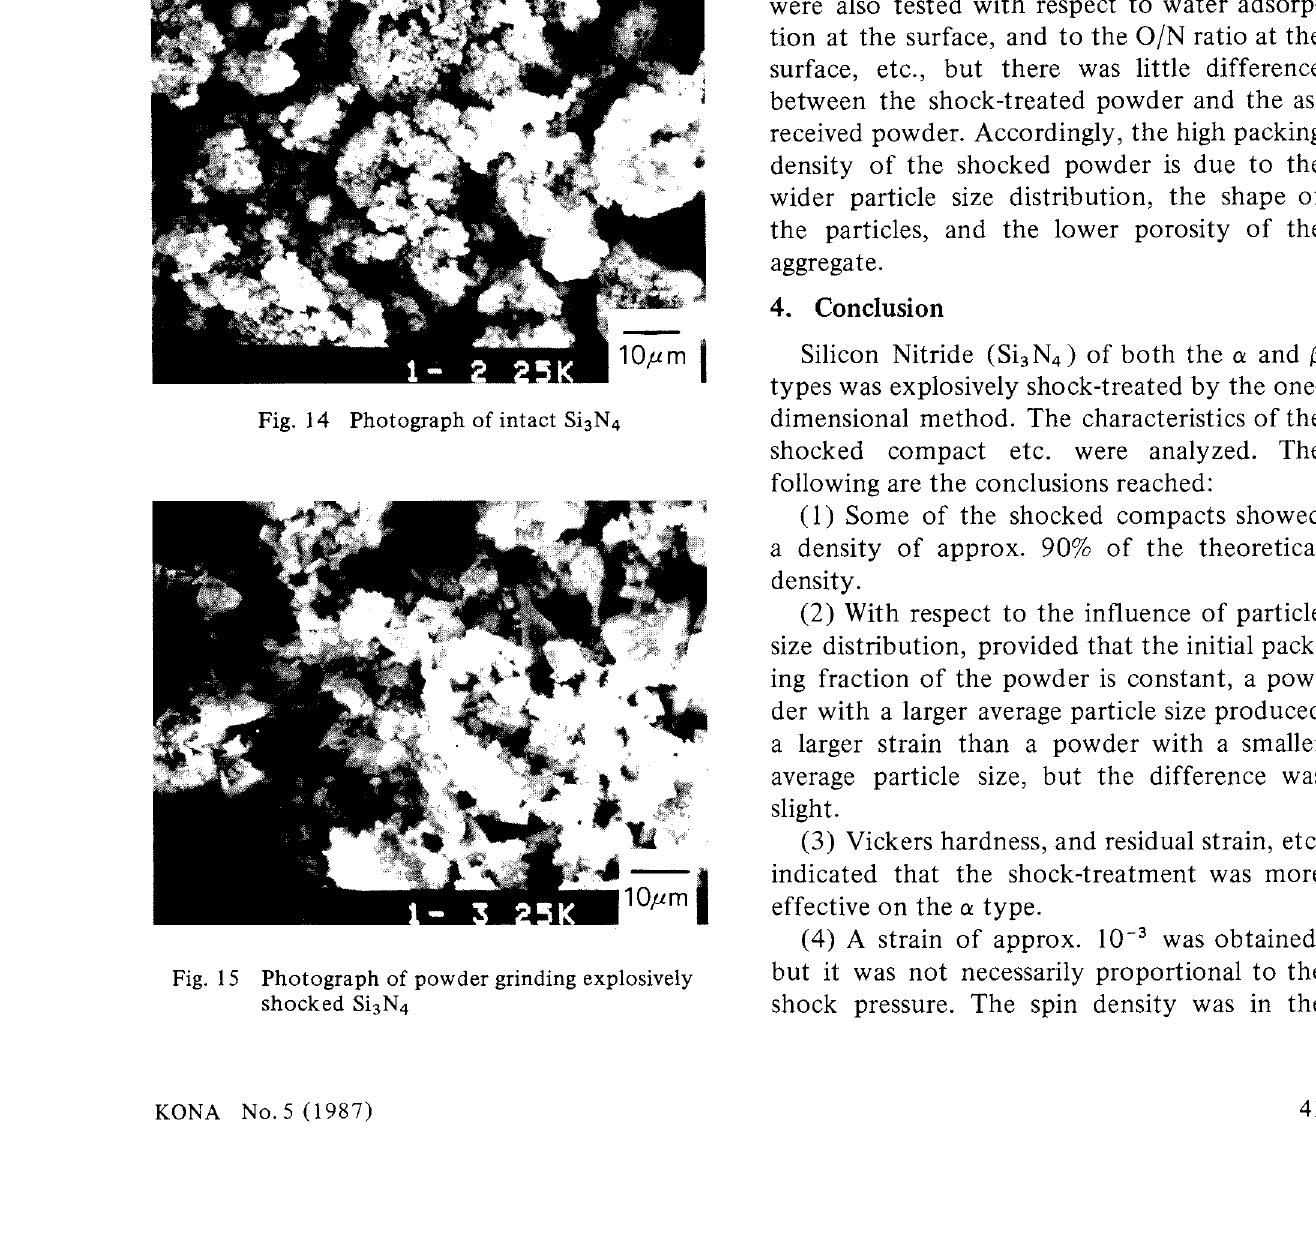
Fig. 14 Photograph of intact Si3N4